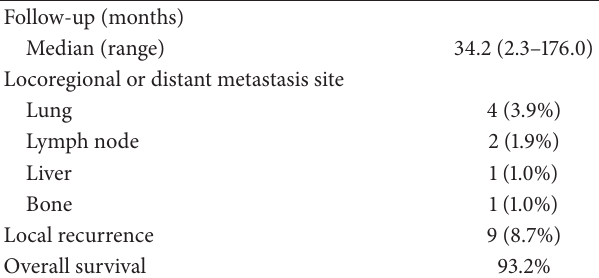
Table 2: Outcome measures following treatment for